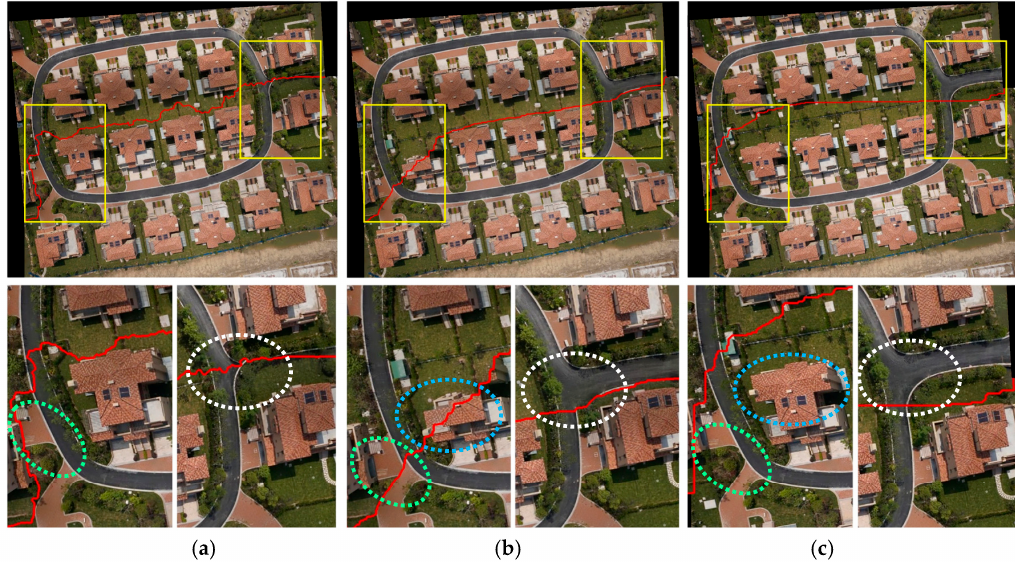
Figure 9. Optimal seam-lines of three test methods for Figure 5c. ( a ) GCC. ( b ) GCCG. ( c ) GCCGOF.